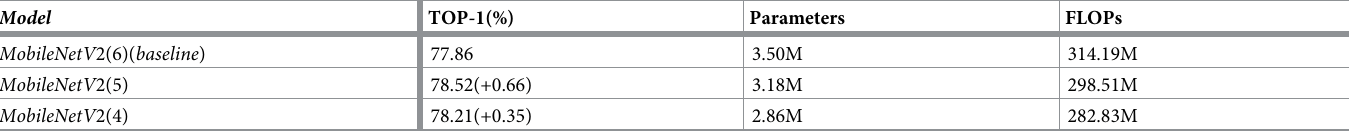
Table 1. Results on IMAGENET-100.